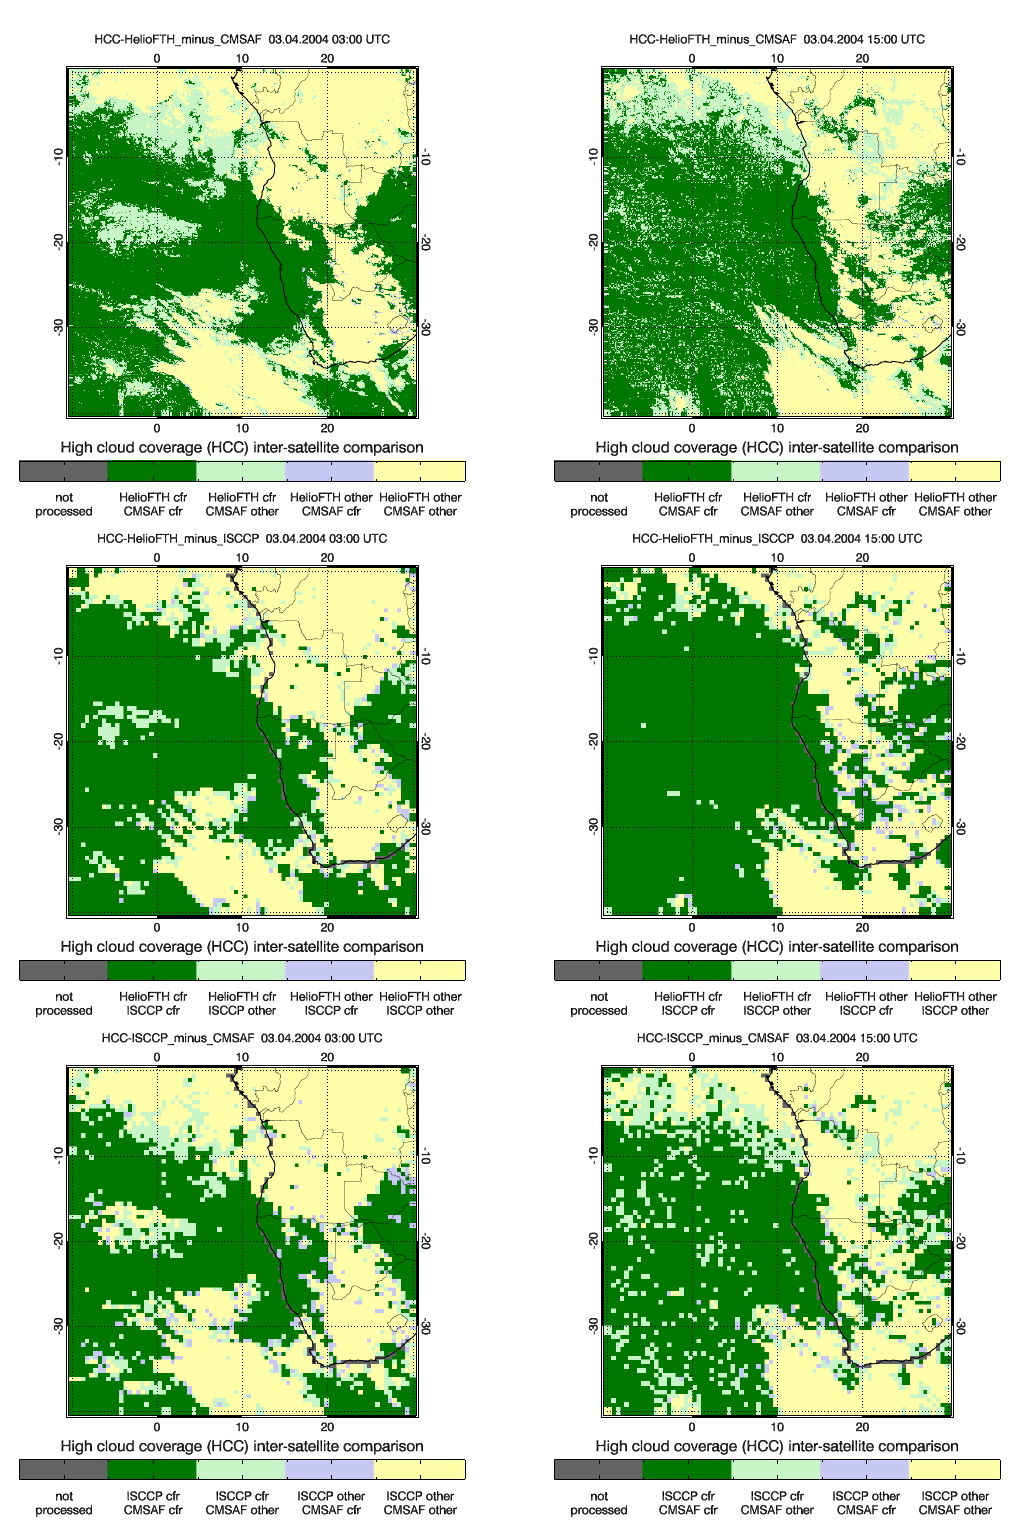
Fig. 5. 3 April 2004: categorical differences in middle and high cloud coverage (HCC) for HelioFTH – CM SAF (top row), HelioFTH – ISCCP-DX (middle row) and ISCCP-DX – CM SAF (bottom row) for nighttime (left column) and daytime (right column).